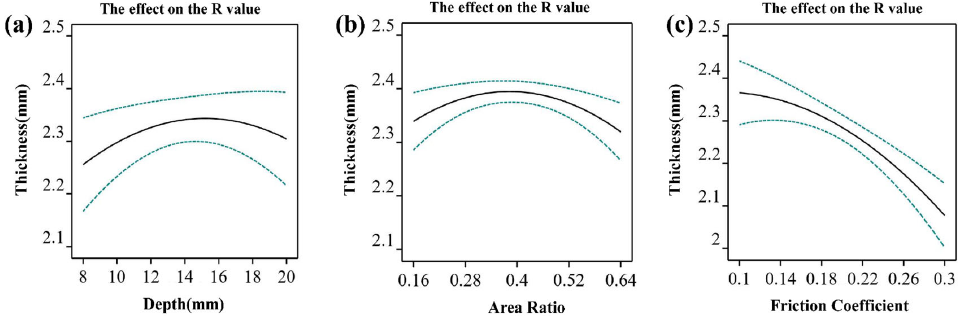
Figure 6. The effect of a single factor on the R ‐ value. ( a ) Depth; ( b ) Area ratio; ( c ) Friction coefficient.